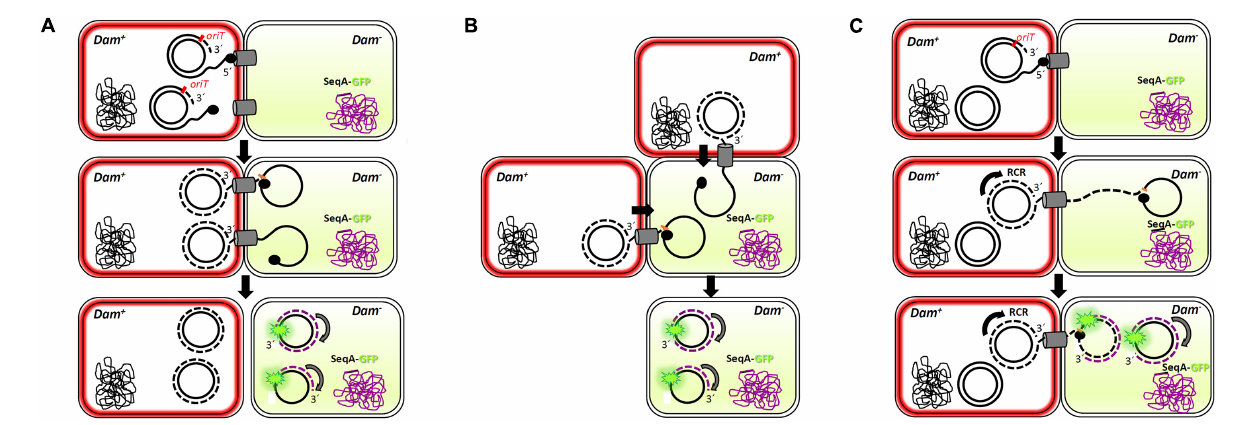
FIGURE 6 | Multi-transfer of conjugative R388 plasmid. The passage of more than one copy of the conjugative plasmid from donor to recipient cells, as shown by the presence of more than one foci in the recipient cell ( Figure 5 ), is compatible with three models. Dam + donor cells contain R388 plasmid copies that express TrwB-mKate2 protein, coloring the membrane in red. Dam - recipient cells express SeqA-GFP protein from the chromosome, under the control of the native SeqA promoter. Methylated DNA is represented in black, whereas no methylated DNA is in purple. SeqA-GFP expression in the recipient cell is diffuse in the absence of hemi-methylated DNA. Only when a methylated copy of the plasmid is transferred and DNA replication starts in the recipient cell, SeqA-GFP is able to form compact foci. In model 1 (A) , conjugation might occur simultaneously from two or more secretion systems in contact with the same recipient cell, giving rise to at least two fluorescent foci. In model 2 (B) , two donor cells would transfer the plasmid simultaneously to the same recipient cell. In model 3 (C) , only one secretion system is functional but, since the transfer of plasmid ssDNA is accomplished of rolling circle replication (RCR) in the donor cell, multiple single-stranded linear copies of the plasmid (a concatemer) would be transferred bound to the relaxase TrwC. Once in the recipient cell, a new cleavage by TrwC on the nic site would re-circularize the plasmid DNA, resolving as many plasmid copies as those present in the concatemer. The synthesis of the complementary non-methylated strand would be associated to SeqA-GFP binding, observed as fluorescent